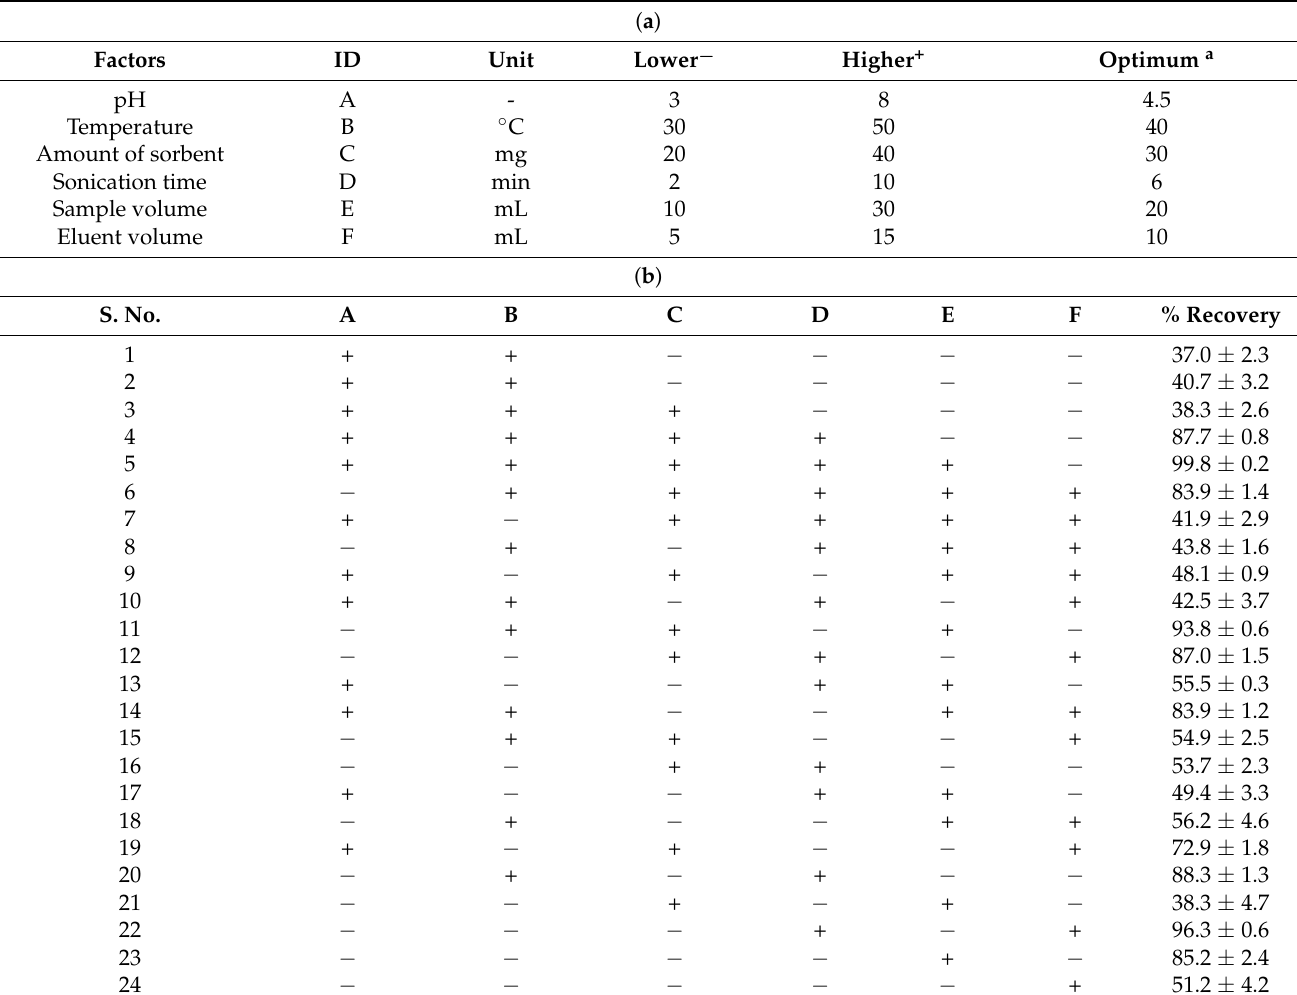
Table 1. ( a ) Factors and levels used in the factorial design. ( b ) Design matrix and the results of % R (n =